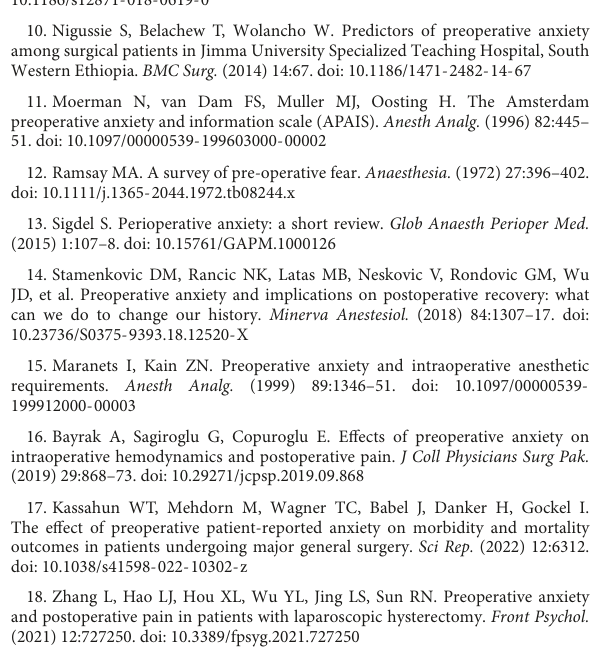
Hiwot referral hospitals, Northwest Ethiopia. BMC Anesthesiol. (2018) 18:155. doi: